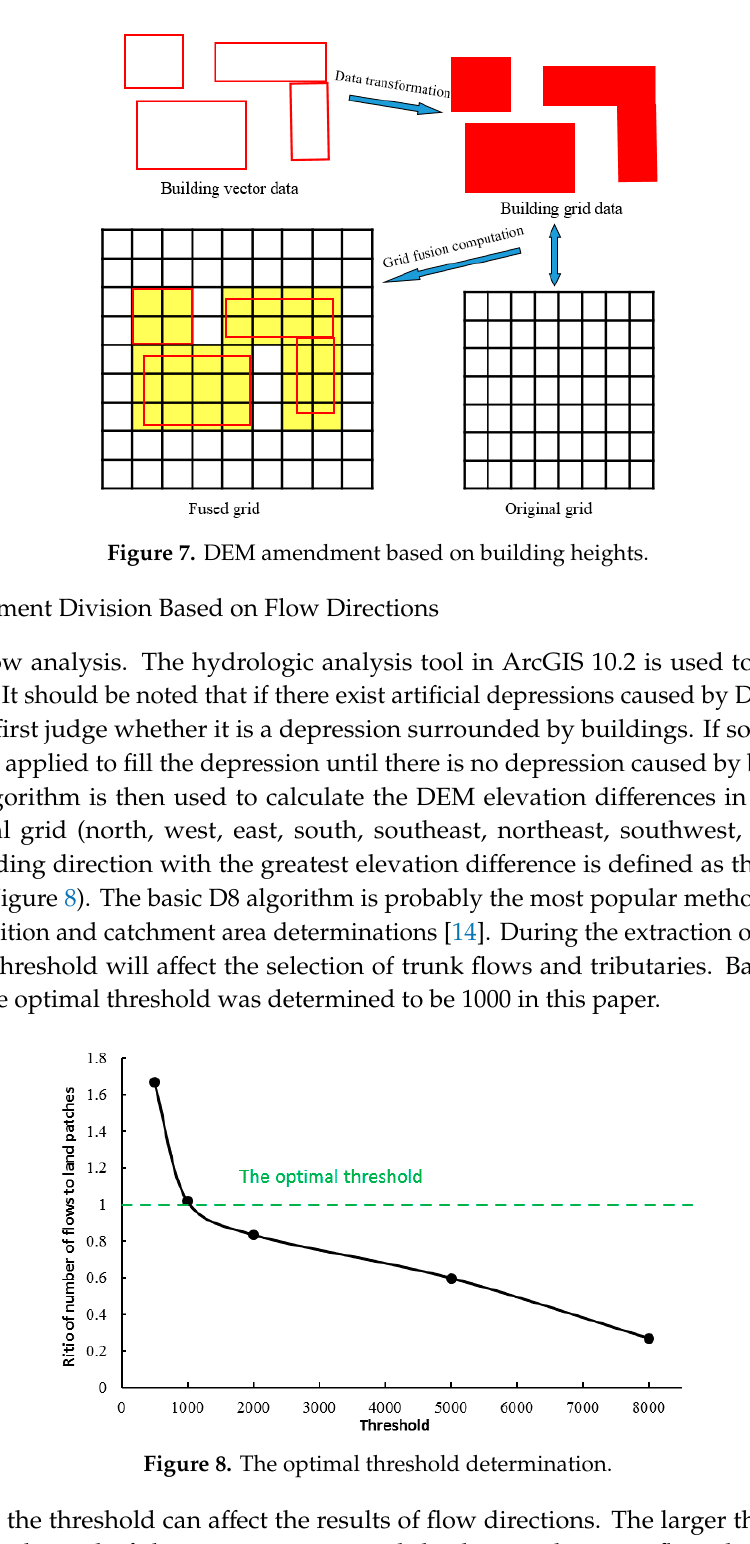
Figure 9. D-B (Direction-Based) catchment division. 3.3.2. The Smallest Catchment Division Based on Land Type Data To accurately determine urban catchments, an iterative fine division algorithm was proposed to partition D-B catchments based on high-precision land-use type data and catch basin data, thus obtaining the smallest catchments (S-catchments). It should be noted that due to that different land uses have different infiltration intensity, generally, the higher the precision of land uses data, the more accurate the catchment area will be. However, high precision land uses data are usually fragmented, which will lead to the difficulty of automatic determination of catchments in large-scale urban area. The proposed algorithm can address this issue. To guarantee the accuracy of the sub- catchments, the land use data used in this paper is derived from the Department of Natural Resources of Shandong Province, China. The data accuracy and quality conformed the standard specification DB37T 2761.2-2016 (Technical specification of geographic information public service platform, Part 2: Framework Data) issued by Shandong Bureau of Quality and Technical Supervision. The land use